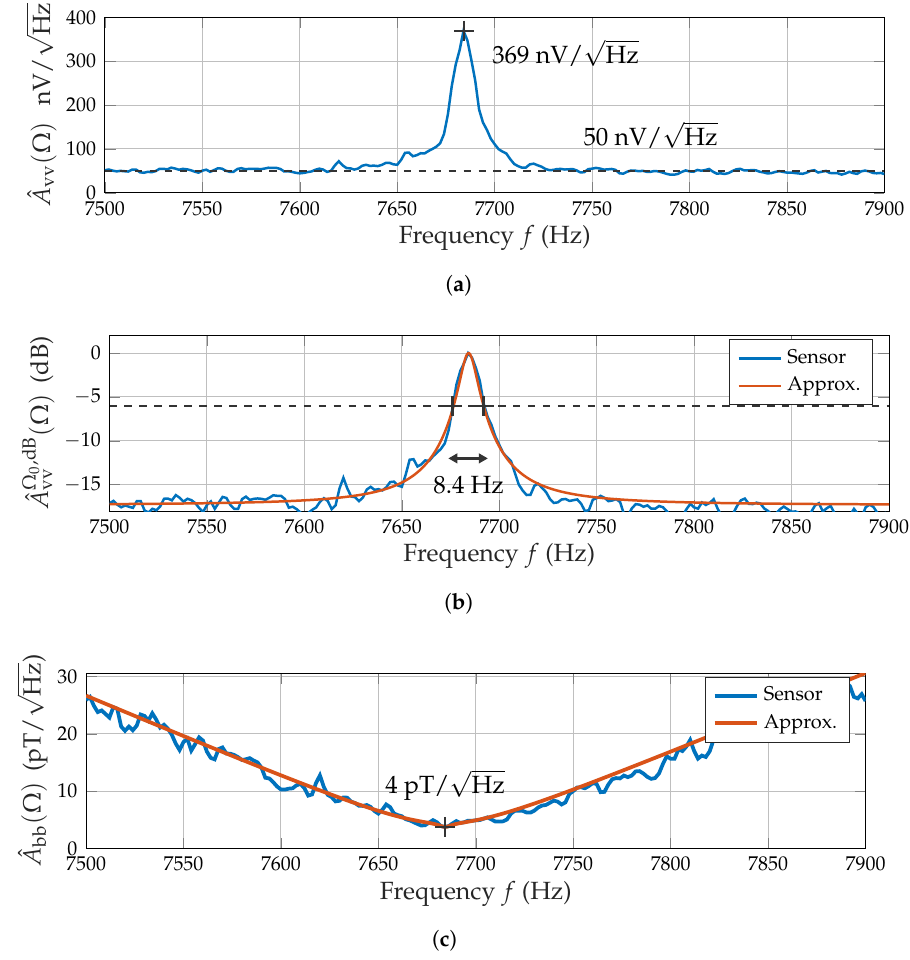
Figure 4. ME sensor noise characteristics. ( a ) Voltage noise spectral density with peak and floor value. ( b ) Normalized noise filter with IIR peak filter approximation defined by 6 dB